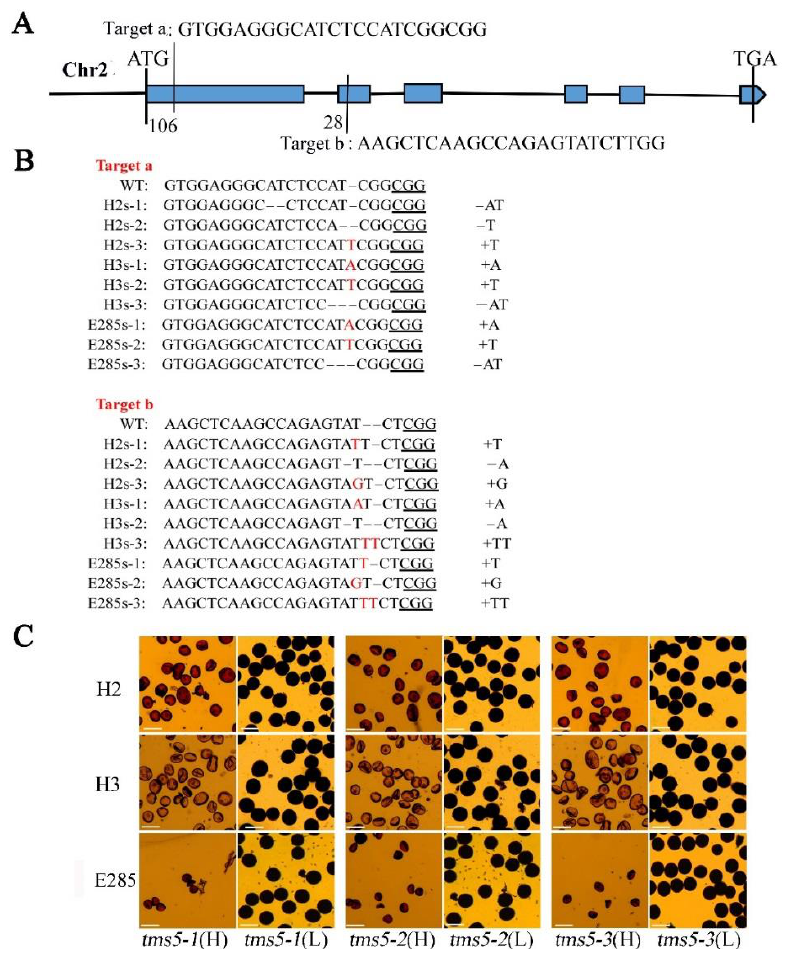
Figure 1. Target location of TMS5 gene, homozygous mutation sequence of T1 generation and pollen fertility. ( A ) Structure of TMS5 gene. The 20 bp adjacent to the underlined protospacer adjacent motifs (PAMs) in wild-type sequence are CRISPR-Cas9 target sequence. Six exons are represented by blue boxes. The first blue box and vertical line indicate 106–128 base position of the first exon that shows the location of the target TMS5a and second blue box and vertical line represent the 28–46 base position of the second exon that shows the location of the target b. ( B ) The target sites of TMS5 gene are consistent with the mutant sequence. Inserted nucleotides displayed in red; ( C ) Pollen fertility of different mutant types at high and low temperatures. H, high temperature; L, low temperature; Bars = 50 µ